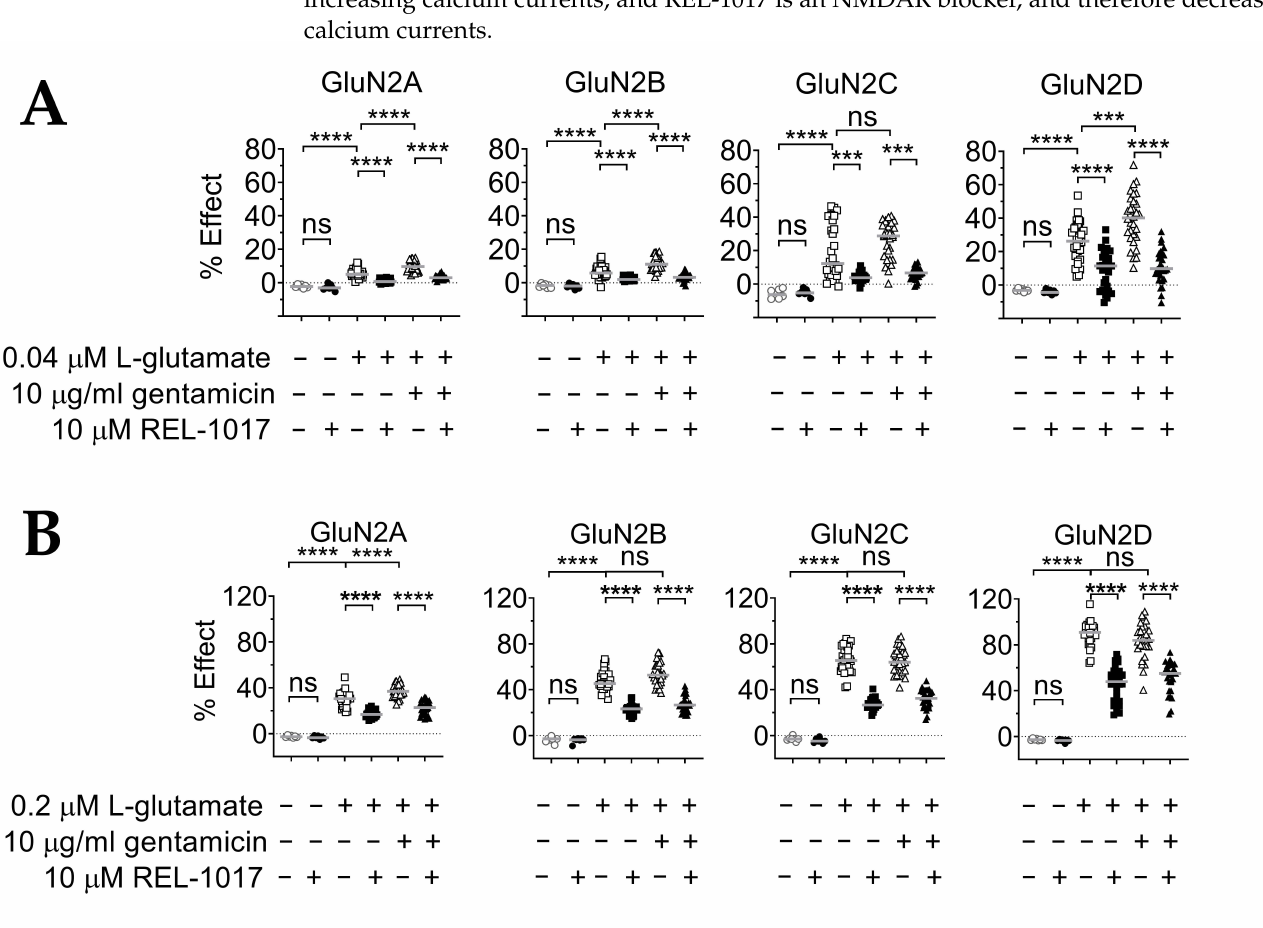
Figure 4. ( A ) Gentamicin was a positive modulator at GluN1-GluN2A, GluN1-GluN2B, and GluN1- GluN2D subtypes, in the presence of 0.04 µ M L-glutamate, and REL-1017 reduced [Ca 2+ ] in in the presence of 0.04 µ M L-glutamate, with or without 10 µ M gentamicin, in all tested NMDARs. In addition, 10 µ M gentamicin was tested in combination with 0.04 µ M L-glutamate; 10 µ M gentamicin significantly increased [Ca 2+ ] in in all cell lines expressing GluN1-GluN2A, GluN1-GluN2B, or GluN1- GluN2D subtypes ( p < 0.0001, p < 0.0001, and p < 0.001, respectively). REL-1017 significantly decreased [Ca 2+ ] in elicited by 0.04 µ M L-glutamate and 0.04 µ M L-glutamate plus 10 µ M gentamicin in all cell lines ( p < 0.0001 in all cell lines and with p < 0.001 in GluN1-GluN2C). Data ( n = 7 wells for buffer and REL-1017 groups, n = 30 wells for the remaining groups) are shown as scatter dot plot, and median value is indicated. ( B ) Gentamicin was a positive modulator at the GluN1-GluN2A NMDAR subtype, in the presence of 0.2 µ M L-glutamate, and REL-1017 reduced [Ca 2+ ] in in the presence of 0.2 µ M L-glutamate, with or without 10 µ M gentamicin, in all cell lines. Furthermore, 10 µ M gentamicin was tested in combination with 0.2 µ M L-glutamate; 10 µ M gentamicin significantly ( p < 0.0001) increased [Ca 2+ ] in only in cell lines expressing GluN1-GluN2A subtypes. REL-1017 significantly ( p < 0.0001) decreased [Ca 2+ ] in elicited by 0.2 µ M L-glutamate and 0.2 µ M L-glutamate plus 10 µ M gentamicin in all cell lines. Data ( n = 7 wells for buffer and REL-1017 groups, n = 30 wells for the remaining groups) are shown as scatter dot plot, and median value is indicated. **** is p < 0.0001; *** is p < 0.001; ns, not statistically